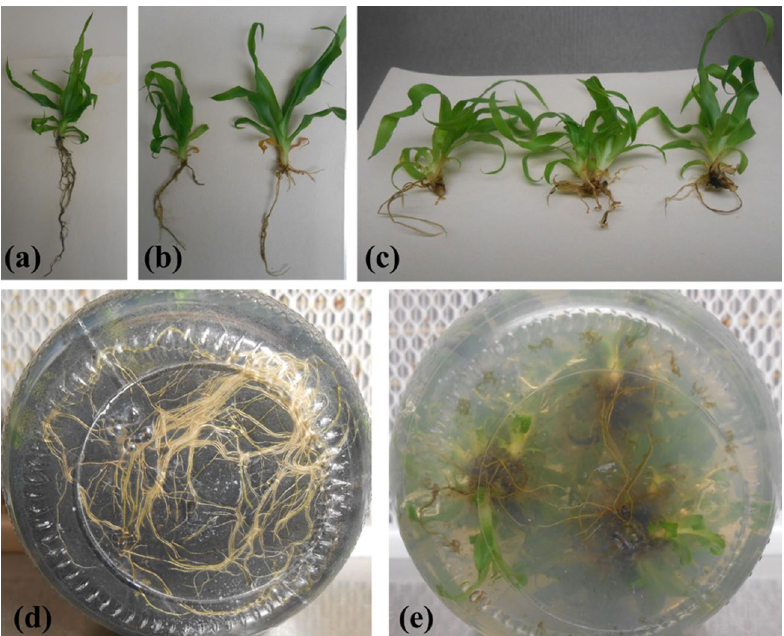
Figure 4. ( a ) Root and shoot growth on the medium containing 1.0 mg L −1 IBA, ( b ) Root and shoot growth on the medium containing 1.0 mg L −1 NAA, ( c ) Root and shoot growth on the medium containing 3.0 mg L −1 IBA, ( d ) Root formation in the plantlets on the medium containing 1.0 mg L −1 IBA ( e ) Root formation in the pineapple plantlets on the medium containing 1.0 mg L −1